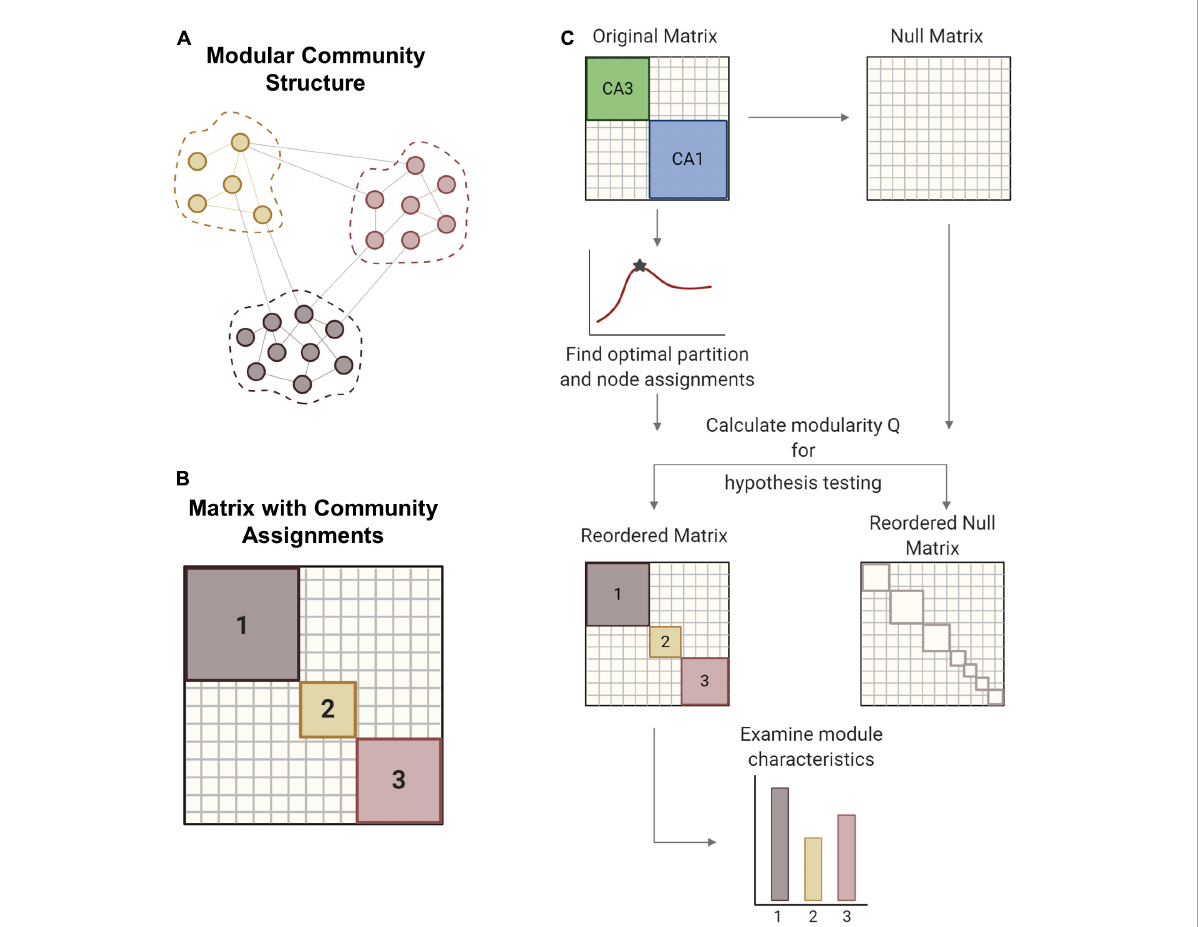
FIGURE2 Modularity methods. (A) Networks can consist of interconnected modules or communities, where similar nodes are grouped with one another. (B) The matrix shows a network representation of community structure where neurons are grouped by module membership. (C) The original empirical matrix is rewired to produce the null matrix, which is a random directed graph with the same input and output degree distributions as the original matrix. The process of community detection maximizes modularity Q to find the optimal community partition. The same parameters are applied to the null matrix and module quality Q is measured for both matrices. Hypothesis testing compares the values of Q between the network of interest and the null model to verify the significance of the identified modular structure. The network is reordered based on community membership. From the reordered matrix, module size and composition can be analyzed. Created with